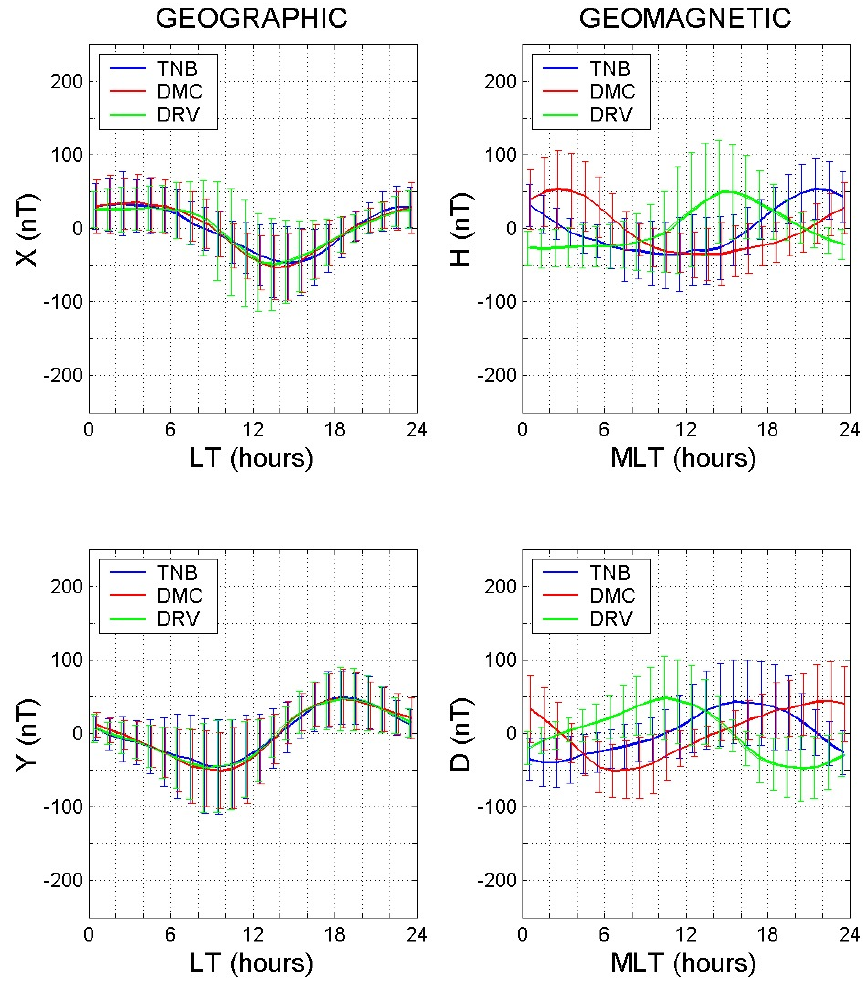
Fig. 5. Daily distribution of the average hourly values and their standard deviation in the geographic reference system (X and Y components, with LT as sorting parameter; left panels), and in the geomagnetic reference system ( H and D components, with MLT as sorting parameter; right panels).